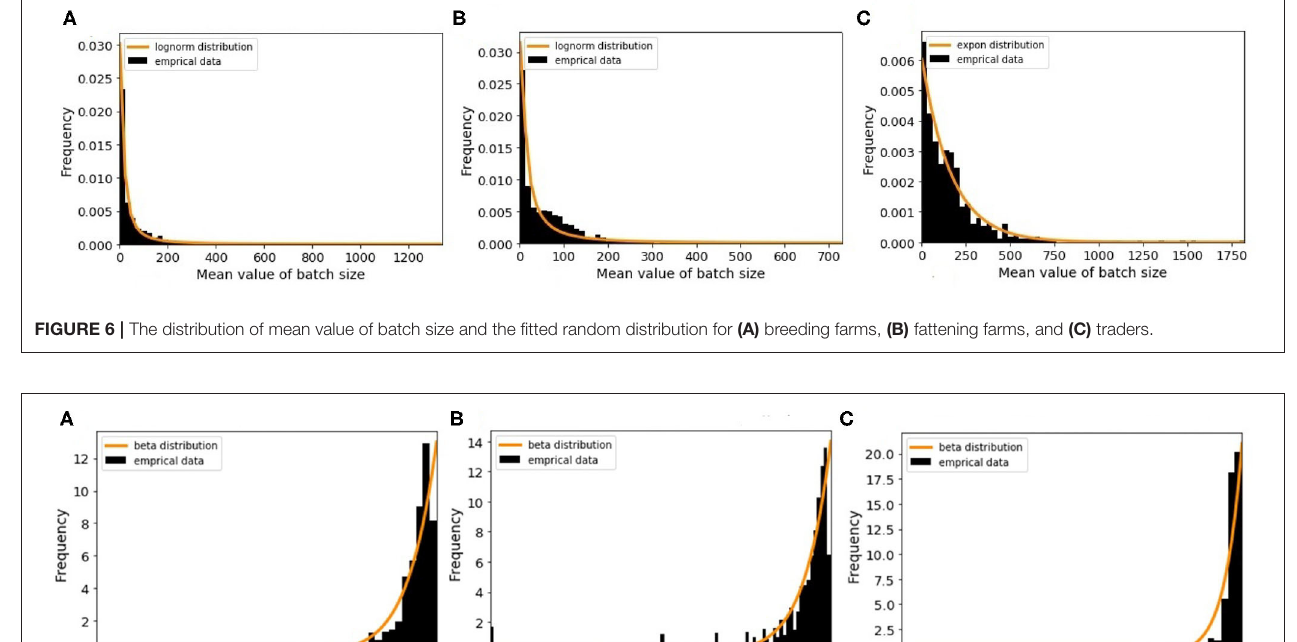
TABLE 5 | Size of components in the real pig trade network and ensemble of 10 generated networks with n = 57,590. Component Real network (%) Ensemble of